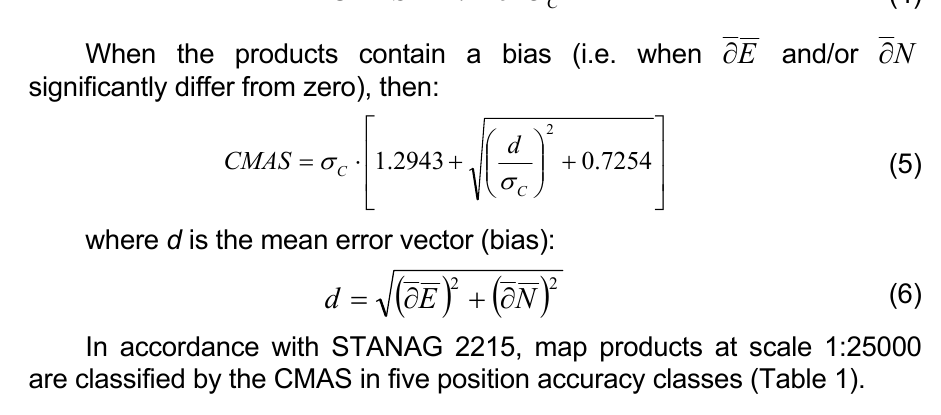
Table 1 – The cartographic products classification by horizontal positional